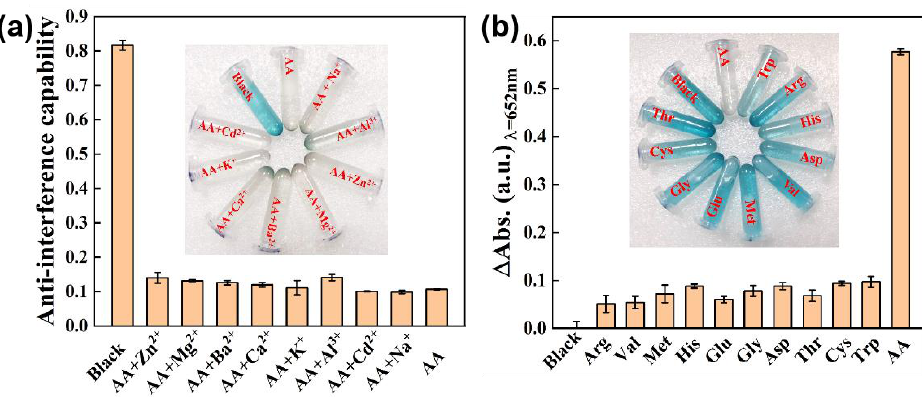
Figure 9. ( a ) Anti-interference ability of the detection platform for AA assay towards coexisting interference substances including Zn 2+ , Mg 2+ , Ba 2+ , Ca 2+ , K + , Al 3+ , Cd 2+ and Na + . ( b ) Selectivity of the detection platform for AA assay. From left to right: Blank, L -arginine, L -valine, L -methionine, L -histidine, L -glutamate, glycine, D L -aspartic acid, L -threonine, L -cysteine, L -tryptophan and ascorbic acid. The error bars represent the standard deviation values of three measurements. The insets are corresponding photographs of color changes.